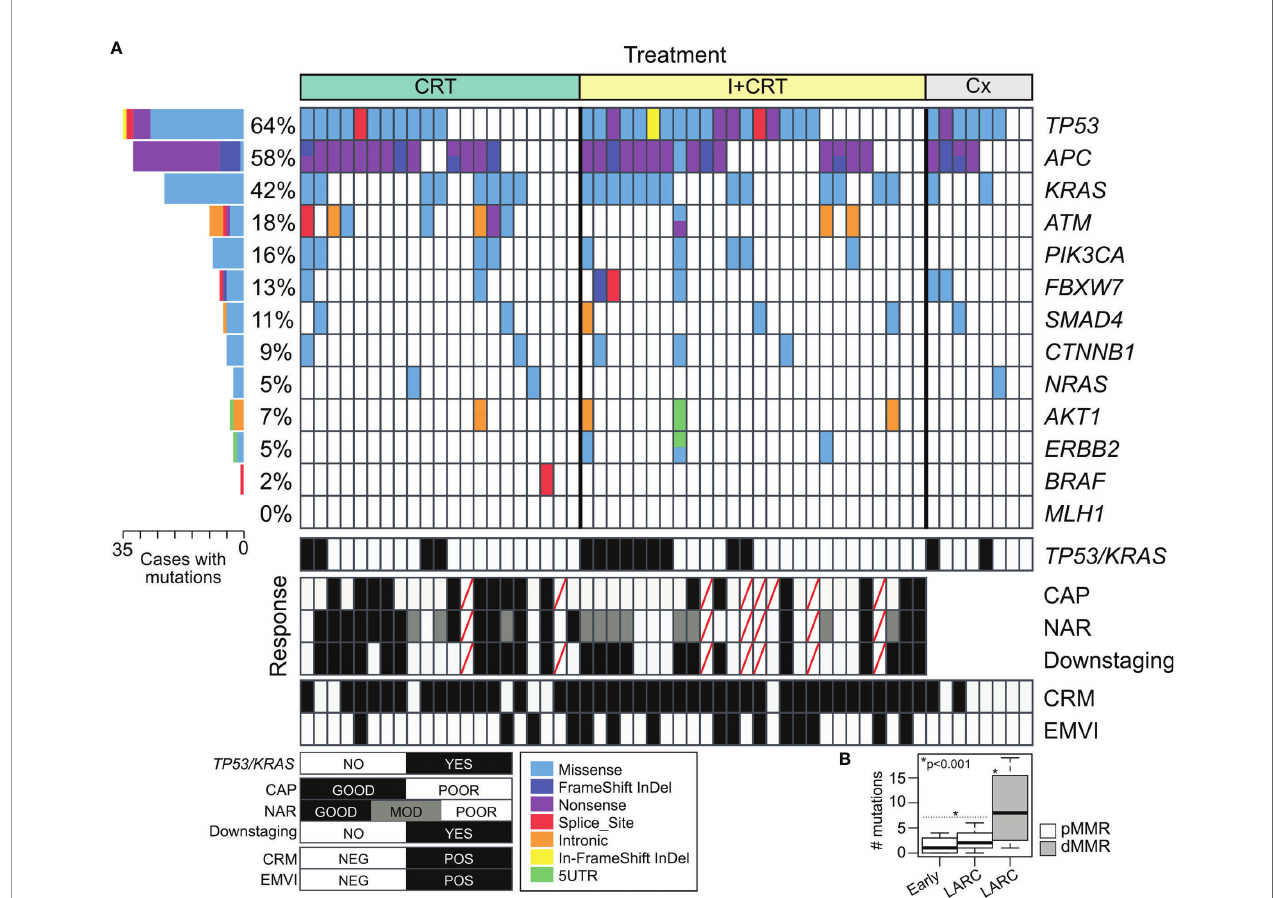
FIGURE 3 | Mutational pro fi le of non-metastatic rectal cancer based on two Targeted DNA Sequencing panels. (A) Tile plot showing recurrent altered cancer driver genes in RC cases according to the treatment assigned and response to the preoperative neoadjuvant treatments. (B) Box plot of the number of mutations in early- stage tumors and locally advanced rectal cancer (LARC) among pro fi cient (pMMR in white) and de fi cient mismatch repair (pMMR in gray) rectal